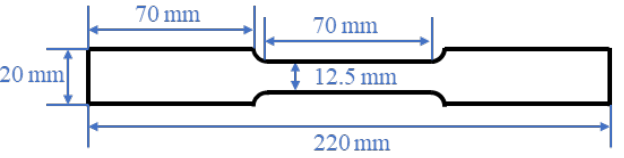
Figure 3. Standard sample size of A 50